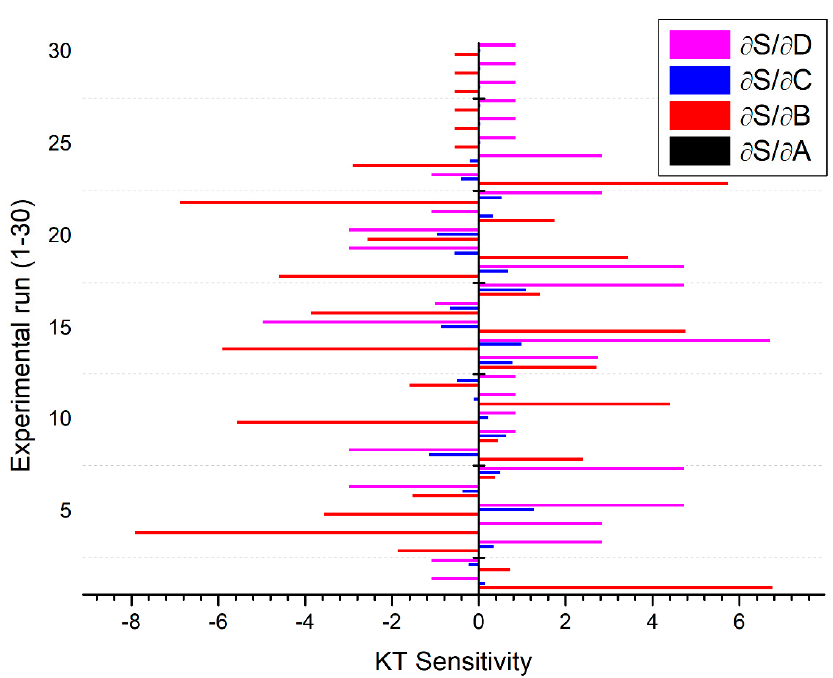
Figure 12. Sensitivity of PAC variables on